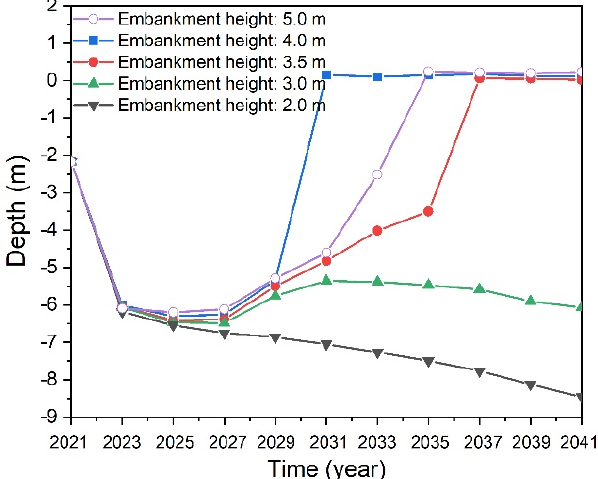
Figure 8. Curves of the variation in permafrost table under the road centerline of different subgrade structures. grade